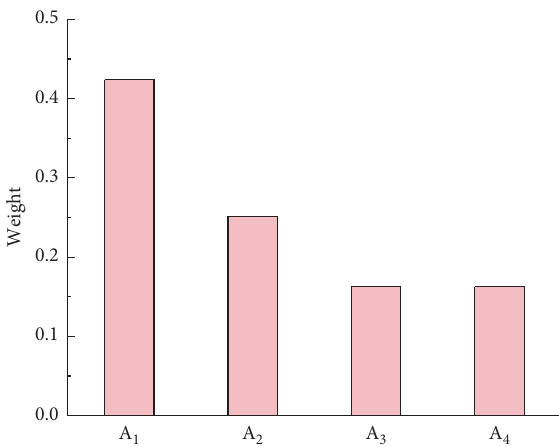
Figure 3: Schematic diagram of hierarchy weight of criterion layer.